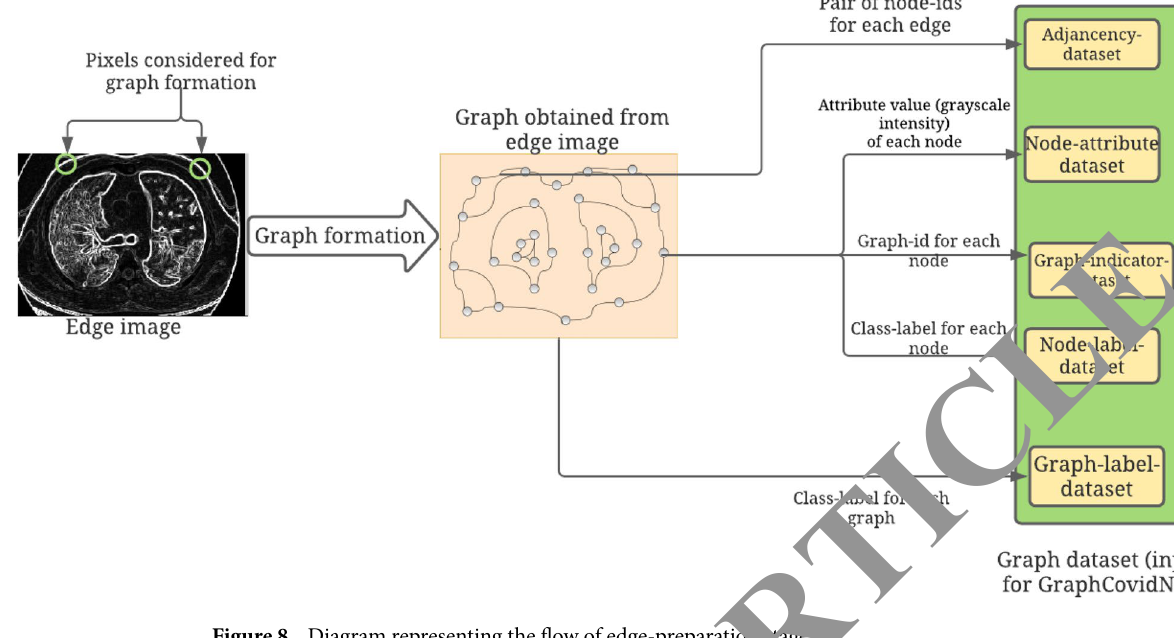
Figure 8. Diagram representing the flow of edge-preparation stage.